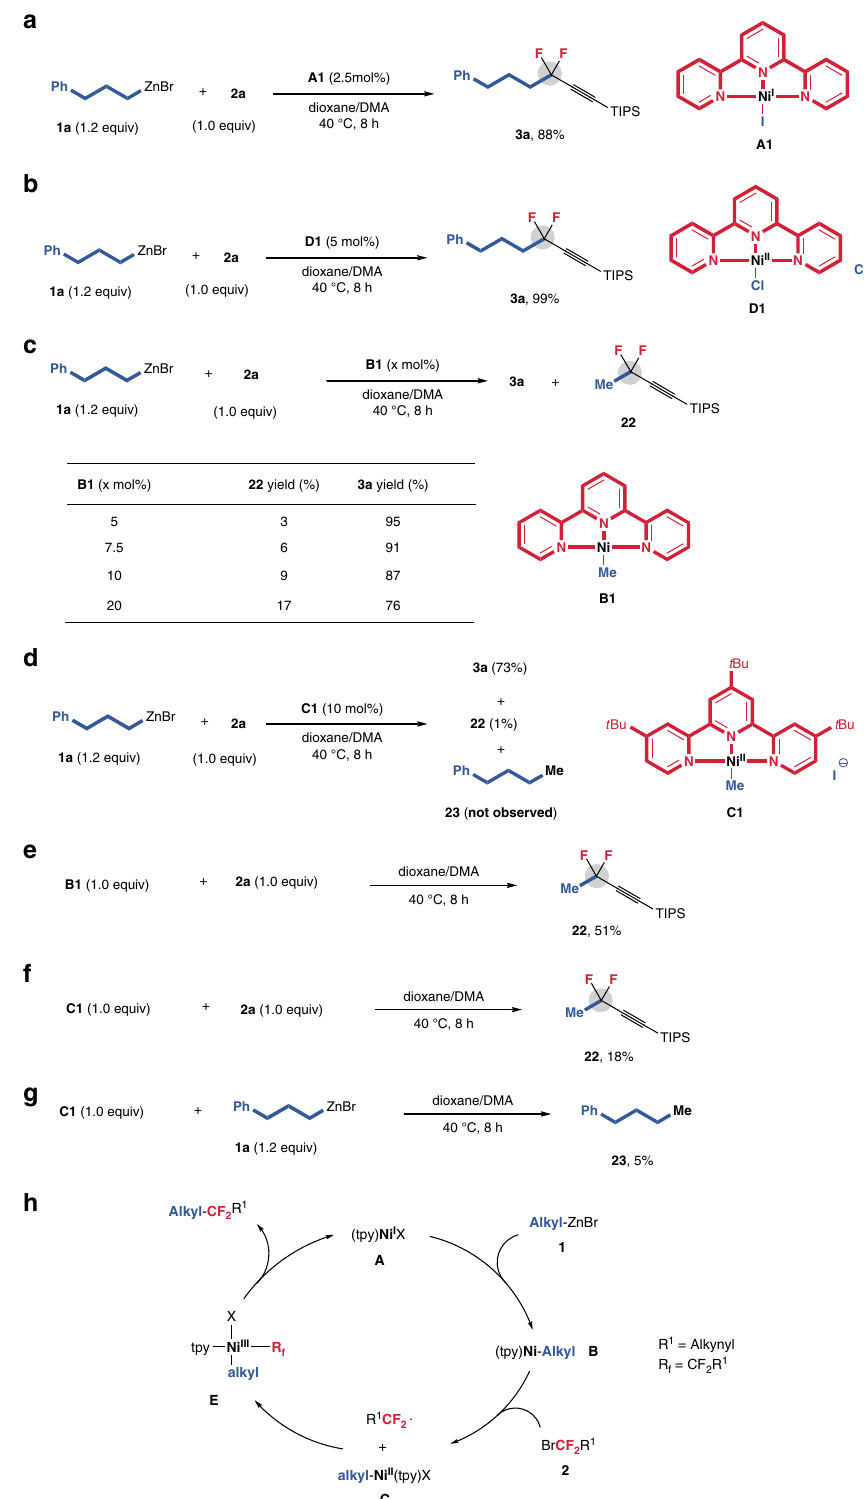
Fig. 3 Mechanistic studies. a A1 catalyzed reaction of 1a with 2a . b D1 catalyzed reaction of 1a with 2a . c B1 catalyzed reaction of 1a with 2a . d C1 catalyzed reaction of 1a with 2a . e Stoichiometric reaction of B1 with 2a . f Stoichiometric reaction of C1 with 2a . g Stoichiometric reaction of B1 with 1a . h Proposed reaction